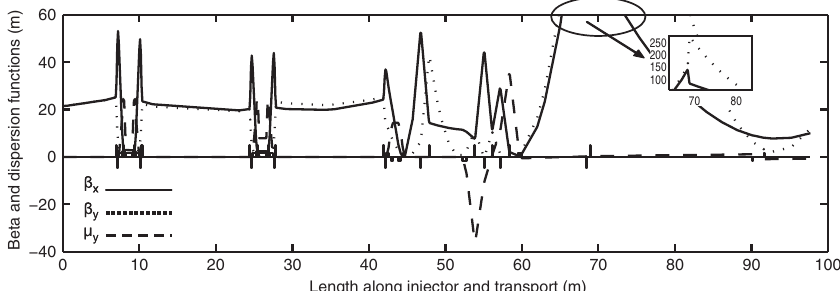
FIG. 4. Twiss parameters. The solid line shows the beta function in the nonbending plane. The dotted and dashed lines show the beta and dispersion functions in the bending